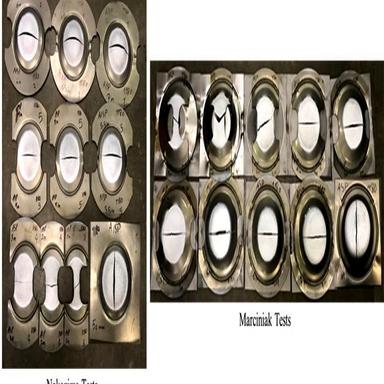
Representative test specimens used to characterize formability of the DP1180 in the transverse direction.